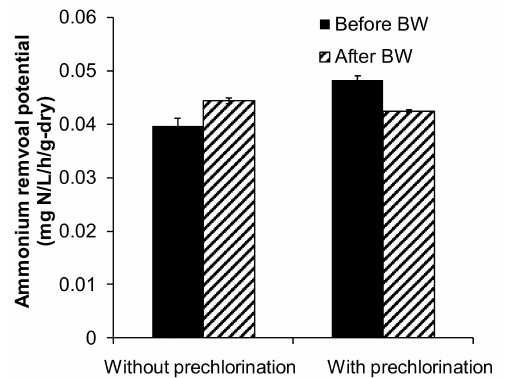
Figure 2. The ammonium removal potential of the GAC before ( (cid:4) ) and after backwashing ( ) in the sampling time of “without prechlorination” and “with prechlorination”. BW: backwashing, and error bar: the standard deviation.